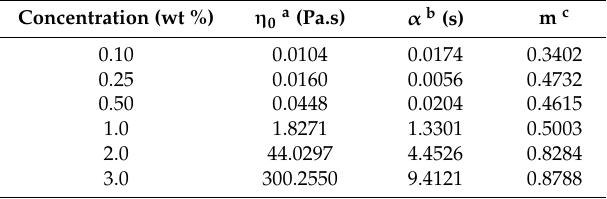
Table 3. Parameters of the Cross model for the range of concentrations studied. Concentration (wt %) η 0 a (Pa.s)